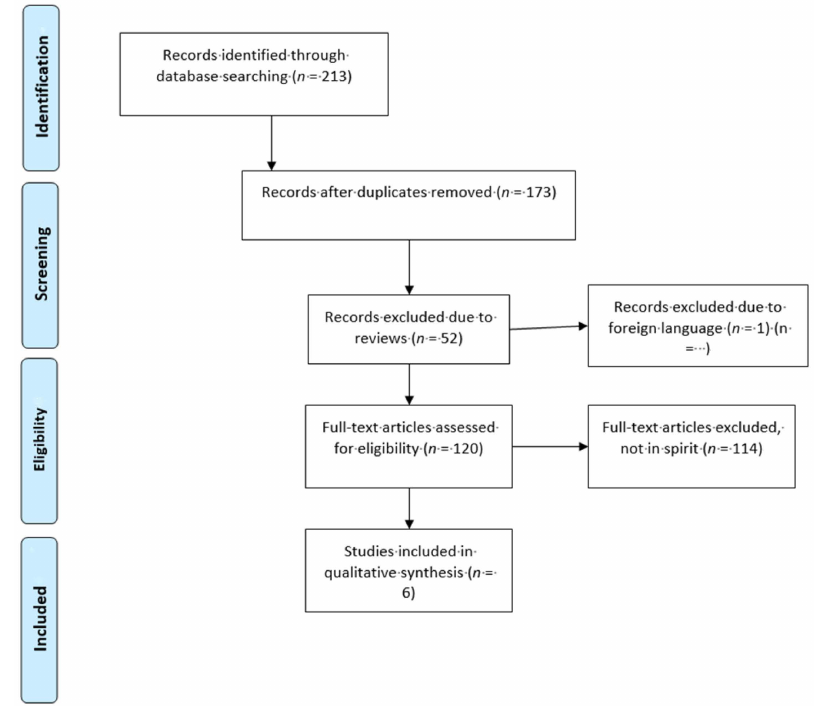
Figure 1. PRISMA flow diagram of studies examining the epigenetic effects of psychopharmacological agents for treating bipolar